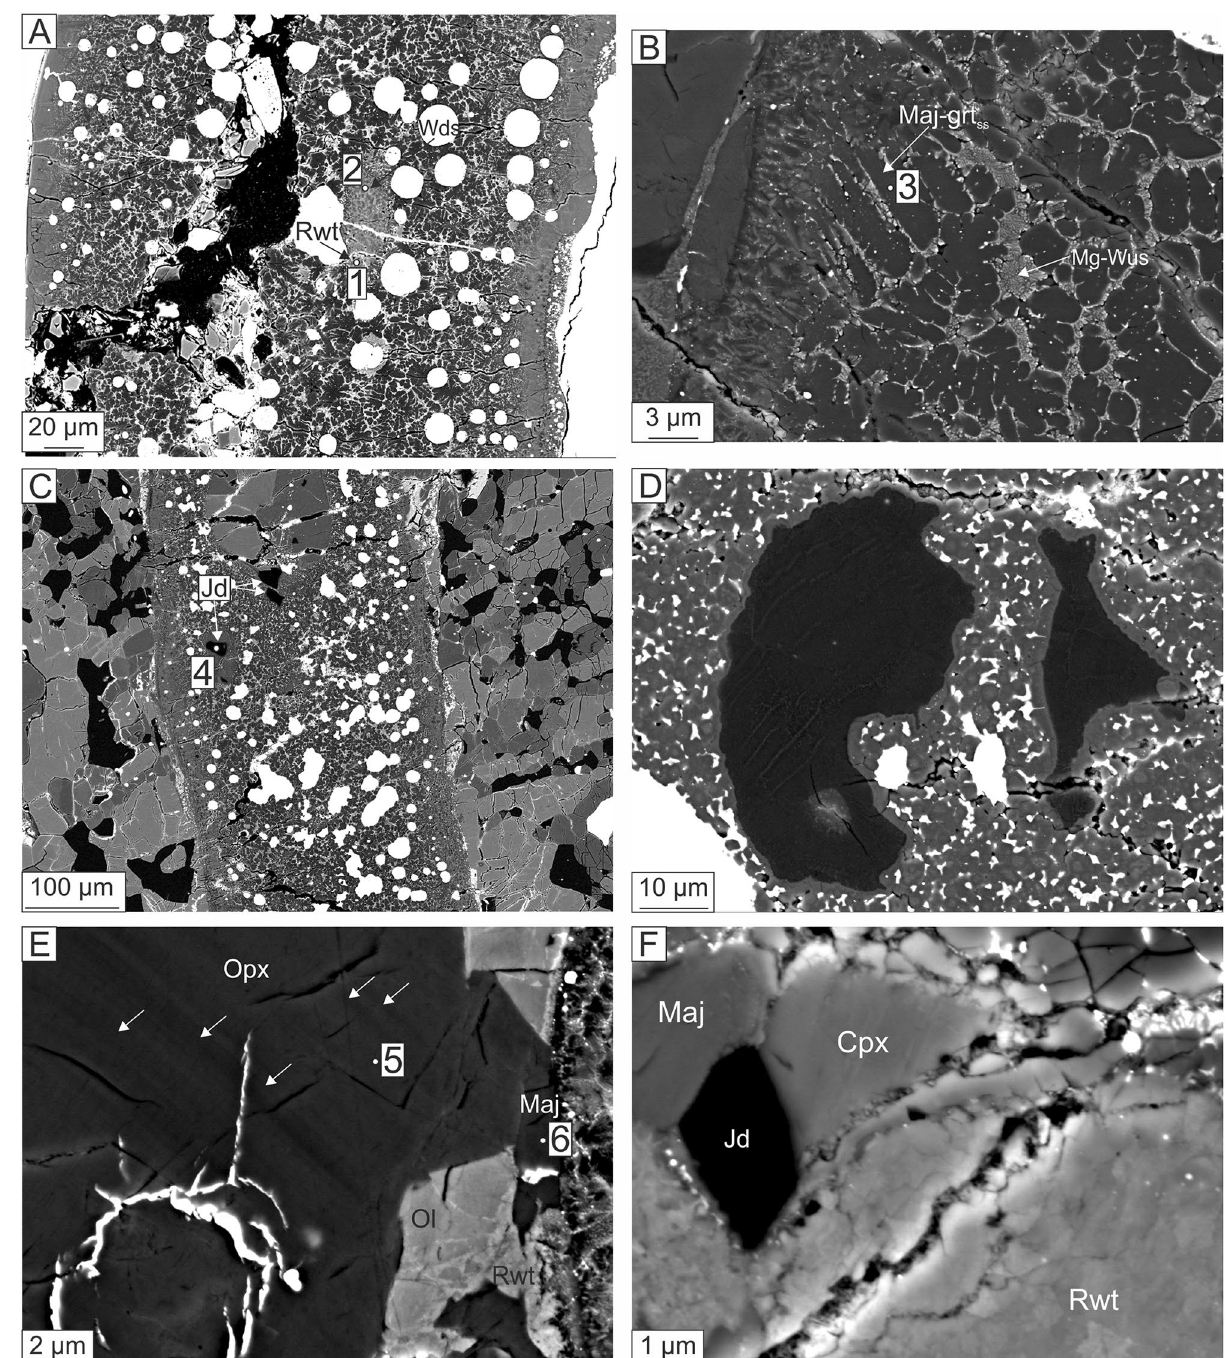
Figure 2. BSE images of MVs in Kakowa. ( A ) MV1a, showing ringwoodite (Rwt) (#1; Raman spectrum MV1a-1 in Fig. 5) in close association with wadsleyite (#2; Raman spectrum MV1a-2 in Fig. 5). ( B ) MV1b, with fine intergrowth of majorite-pyrope solid solution (Maj-grt) (#3, Raman spectrum MV1b-3 in Fig. 5) and magnesiowüstite (Mg-Wus). ( C ) MV2, hosting albitic jadeite (Jd) (#4; Raman spectrum MV2–4 in Fig. 5). ( D ) Glass of feldspathic composition in MV2 showing albitic jadeite lamellae. ( E ) Groundmass orthopyroxene (Opx) (#5; Raman spectrum MV1b-5 in Fig. 5) in contact with MV1b. The bands across the Opx are likely mechanical twin planes (indicated by white arrows) due to shock 5 . Further, at the contact with MV, Opx is transformed to majorite (#6; Raman spectrum MV1b-6 in Fig. 5) and olivine (Ol) is partly transformed to ringwoodite. ( F ) MV2, Albitic jadeite in contact with majorite and